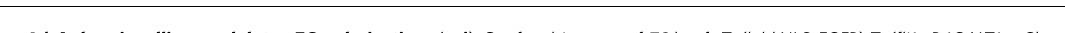
Figure 4 | Aplnr signalling modulates EC polarization. ( a – i ) Confocal images of 72h.p.f. Tg(kdrl:NLS-EGFP);Tg(fli1a:B4GALT1-mCherry) wild-type ( a – c ) aplnra þ / (cid:2) ( d – f ) and aplnrb þ / (cid:2) ( g – i ) larvae. Left panels: ( a , d , g ) three-dimensional (3D)-rendered confocal images of the trunk region; left centre panels: ( b , e , h ) 3D-rendered confocal images of the white boxed region in the left panels; right centre panels: ( b’ , e’ , h’ ) 3D surface-rendered images of the centre left panels; right panels: ( c , f , i ) single plane images of the boxed region in the left panels. White arrowheads point to polarized ECs and yellow arrowheads point to non-polarized ECs. Yellow dashed lines denote the ventral boundary of the DA. White dashed lines denote the boundary of the DA in the single plane images. Red bars indicate the diameter of the DA. White dashed arrows denote the direction of blood flow. ( j ) Quantitative analysis of EC polarization in 72h.p.f. wild type, aplnra þ / (cid:2) and aplnrb þ / (cid:2) larvae. The numbers of larvae ( n ) and ECs ( n’ ) are indicated above the graph. *** P o 0.05. ( k ) Design of the transplantation experiments: Tg(kdrl:NLS-EGFP);Tg(fli1a:B4GALT1-mCherry) wild type or aplnrb þ / (cid:2) cells were transplanted into wild type AB hosts and the transgenic ECs in the DA scored for polarization at 72h.p.f.. ( l – o ) Three-dimensional-rendered confocal images of 72h.p.f. Tg(kdrl:NLS-EGFP);Tg(fli1a:B4GALT1-mCherry) wild-type hosts with wild-type ( l , m ) or aplnrb þ / (cid:2) ( n – o ) transplanted cells. ( p ) Quantitative analysis of EC polarization of wild type or aplnrb þ / (cid:2) cells transplanted into wild-type hosts. The numbers of larvae ( n ) and ECs ( n’ ) are indicated above the graph. ( q – t ) Confocal images of 72h.p.f. Tg(kdrl:NLS-EGFP);Tg(fli1a:B4GALT1-mCherry) wild type ( q , r , u ) and apln (cid:2) / (cid:2) ( s – u ) larvae. The white boxes in the left panels ( q , s ) are enlarged in the right panels ( r , t ). ( u ) Quantitative analysis of EC polarization in 72h.p.f. wild type and apln (cid:2) / (cid:2) larvae. The numbers of larvae ( n ) and ECs ( n’ ) are indicated above the graph. Anterior to the left, dorsal to the top. Scale bars, 20 m m. D, donor; DA, dorsal aorta; H, host; PCV, posterior cardinal vein. Error bars,